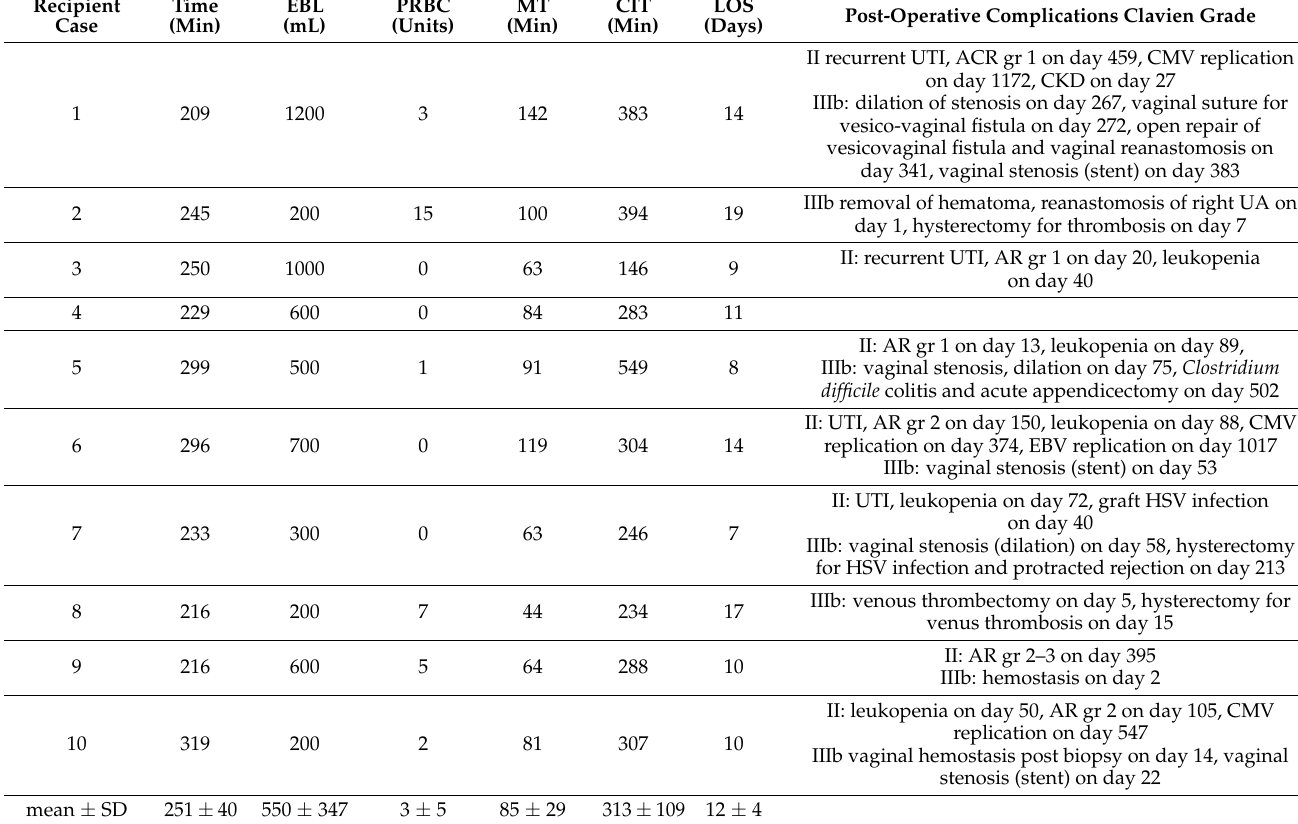
Table 3. Operative details and post-operative complications of 10 consecutive uterus transplant recipients. All surgeries were open laparotomy procedures. There were no intra-operative complications. Only the first episode necessitating therapy of a respective type of complication is